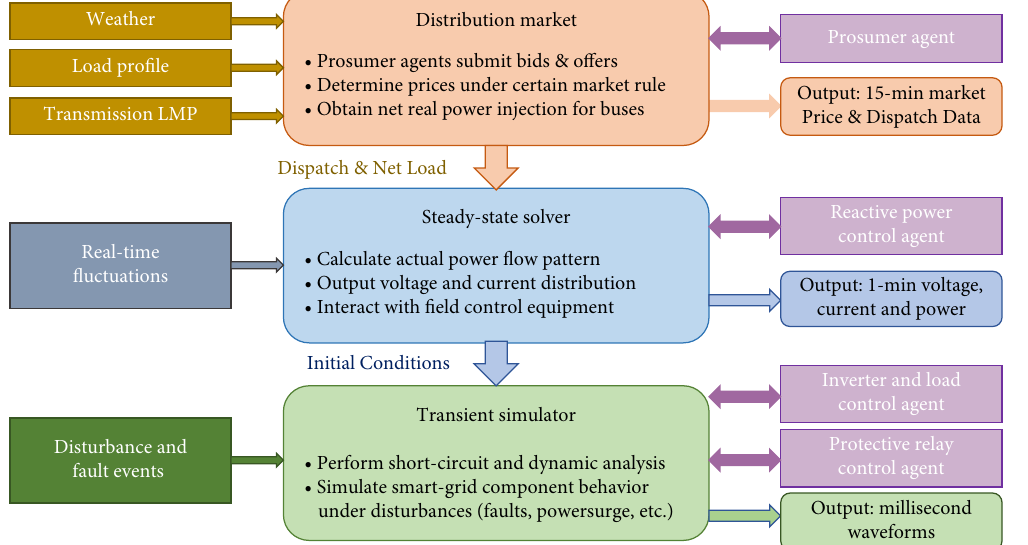
Fig. 3 Architecture of